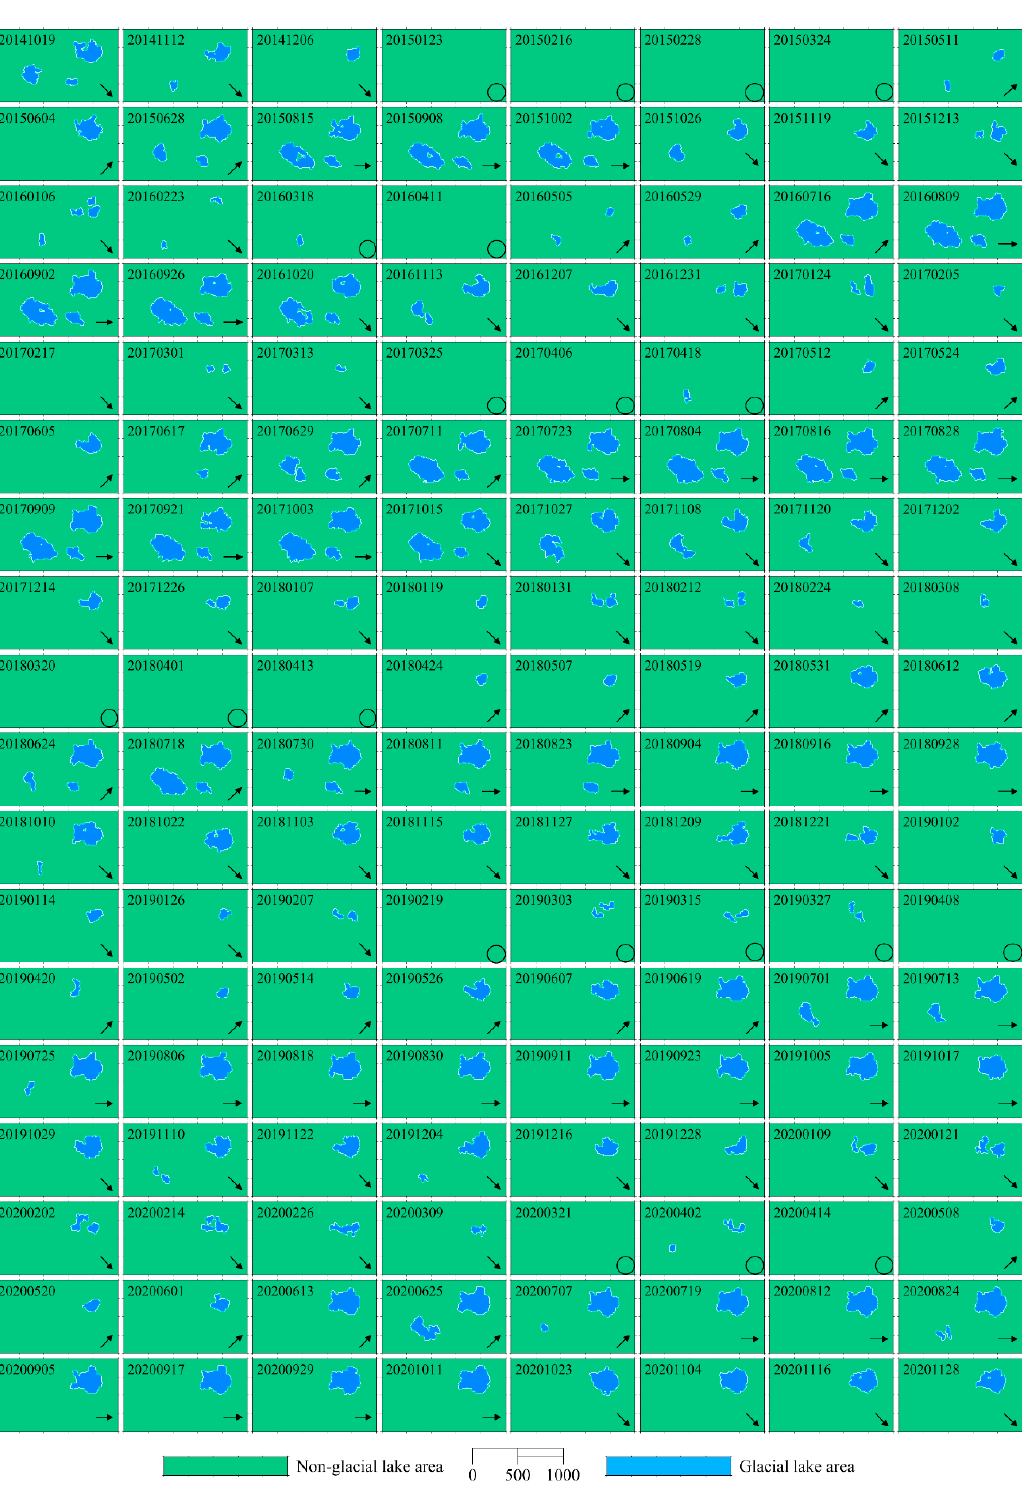
(cid:35) indicating it is dynamically stable and completely